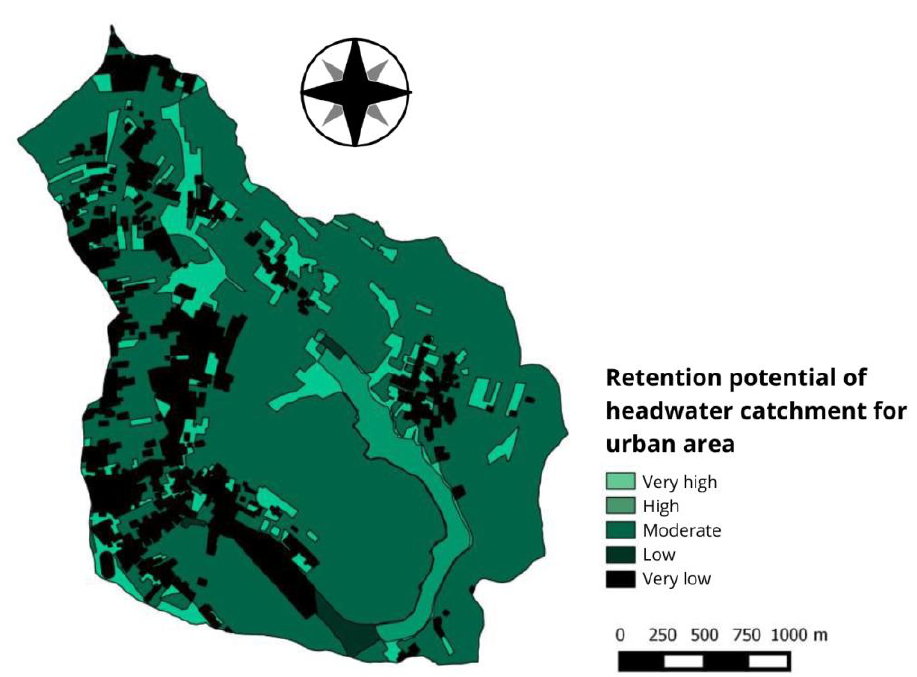
Figure 8. Maximum potential retention for rural area.